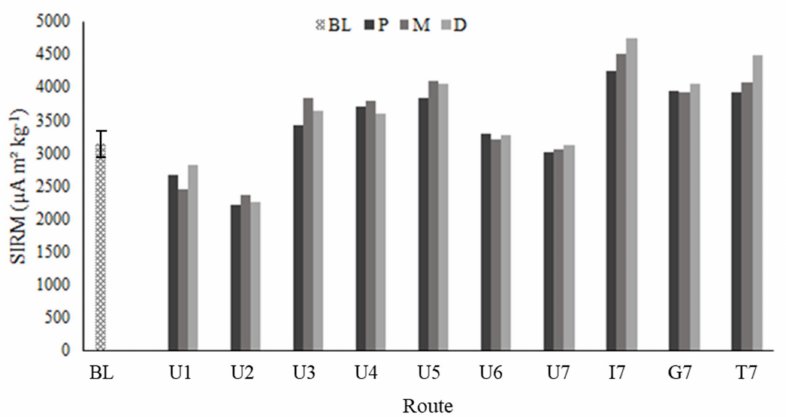
Figure 1. Saturation isothermal remanent magnetization (SIRM) value ( µ A m 2 kg − 1 ) of the unexposed moss (BL) and of the proximal (P), middle (M), and distal (D) moss-bags exposed along the cycling routes (see text for explanation of route codes).